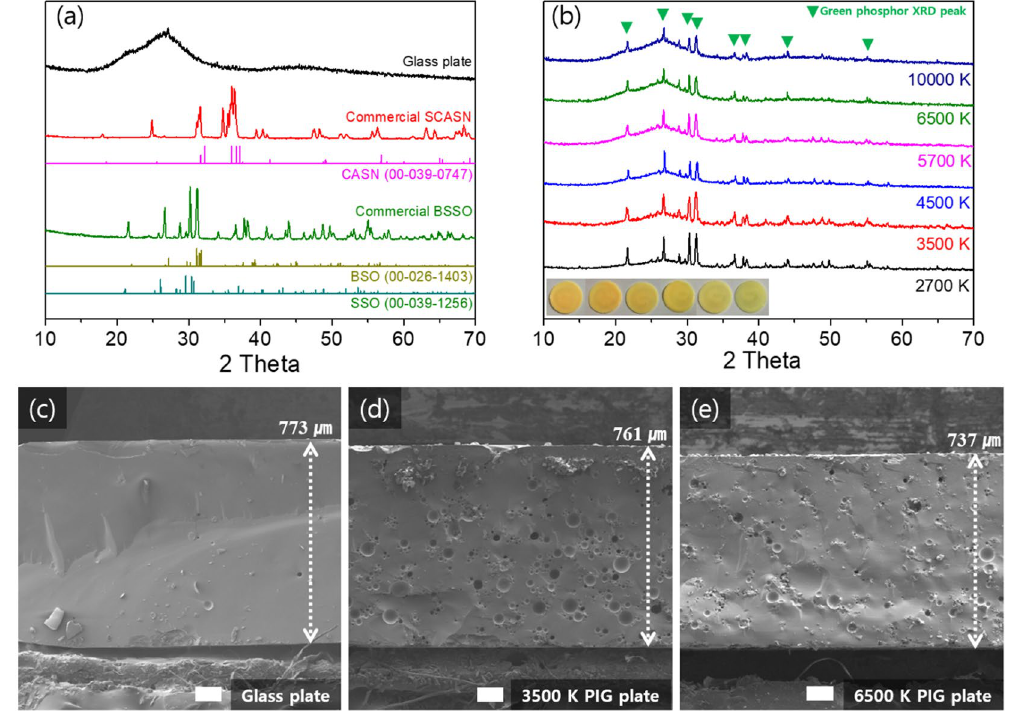
Figure 3. XRD patterns of ( a ) a bare glass plate, BSSO green, SCASN red powder phosphors, and ( b ) green and red phosphor-mixed PIG plates as a function of 2700–10000 K CCTs. The reference XRD peaks of BaSiO 4 , (BSO), SrSiO 4 (SSO) (JCPDS: 00-026-1403, and 00-039-1256, respectively), and CaAlSiN 3 (CASN) (JCPDS: 00- 039-0747) are introduced for indexing the diffraction peaks of green and red phosphor, respectively. The inset shows actual images of a PIG plate in which the CCTs increase from left to right. Cross-section SEM images of ( c ) a bare glass plate, ( d ) a PIG plate at 3500 K, and ( e ) a PIG plate at 6500 K with the white bars showing a 100 μ m